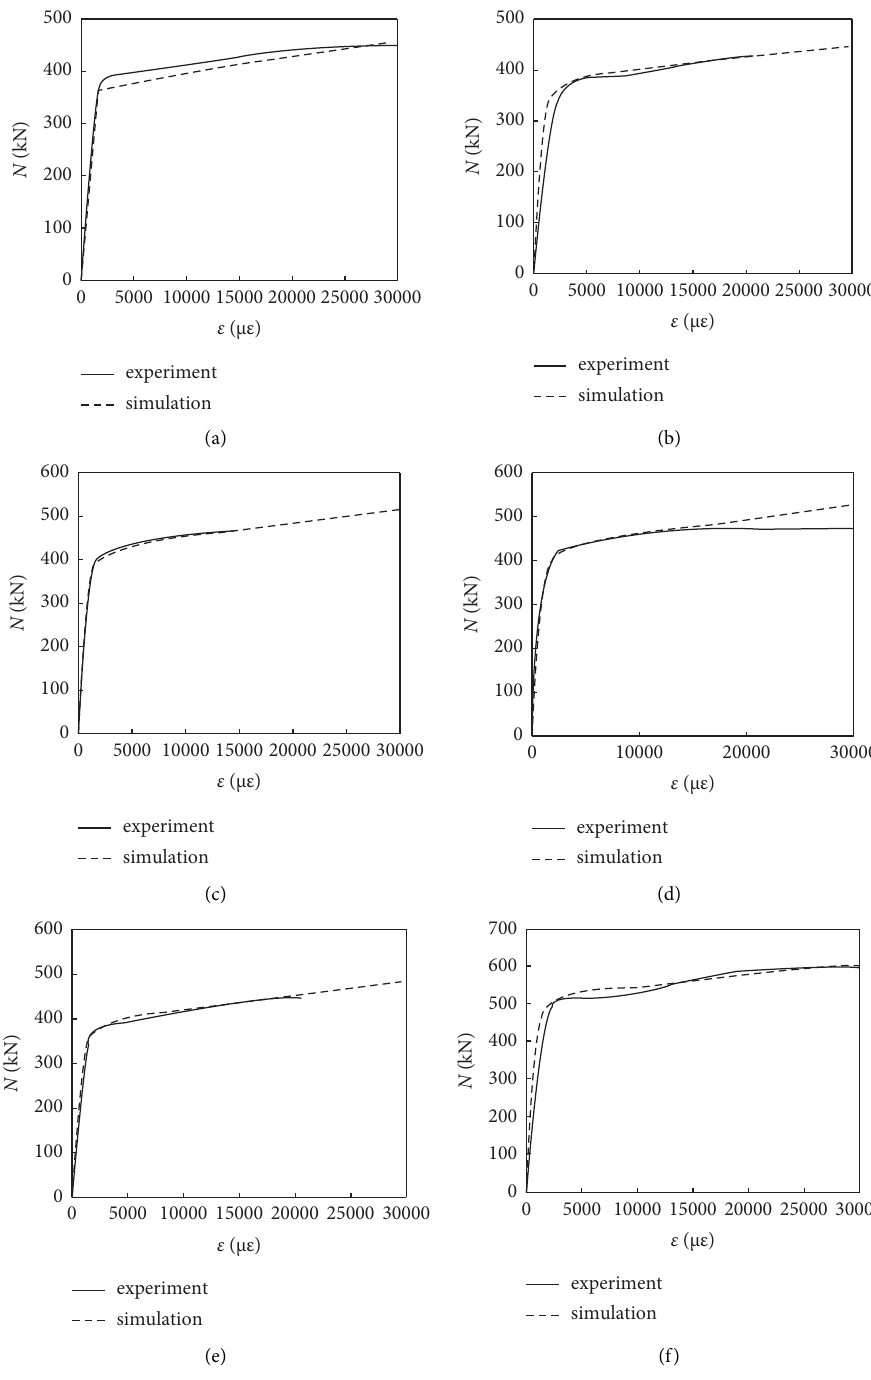
Figure 18: Comparison of test results and fnite element calculation results: (a)114-0, (b) 89-40, (c) 114-30, (d) 114-40, (e) 114-50, and (f)